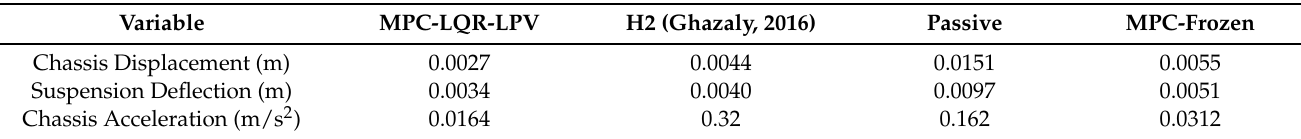
Table 4. Peak Values